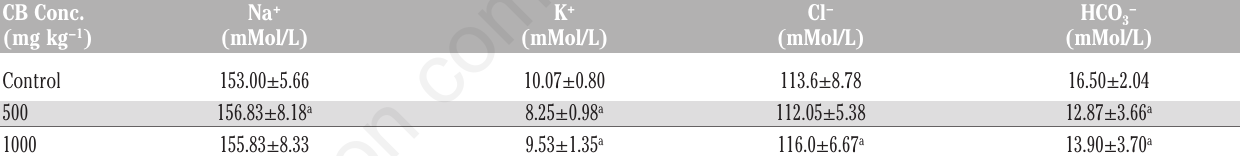
Table 1. Effect of oral administration of class bitters ® on serum electrolytes. CB Conc.